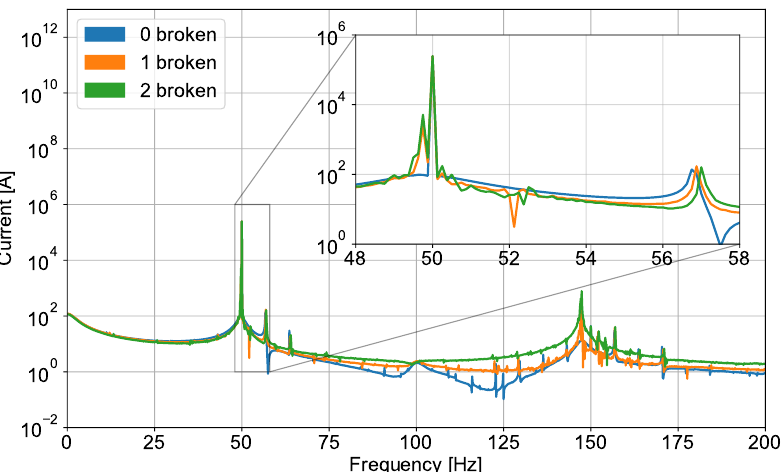
Figure 8. FFT of a simulated current signal (one phase). The frequency range is limited to 0–200 Hz.